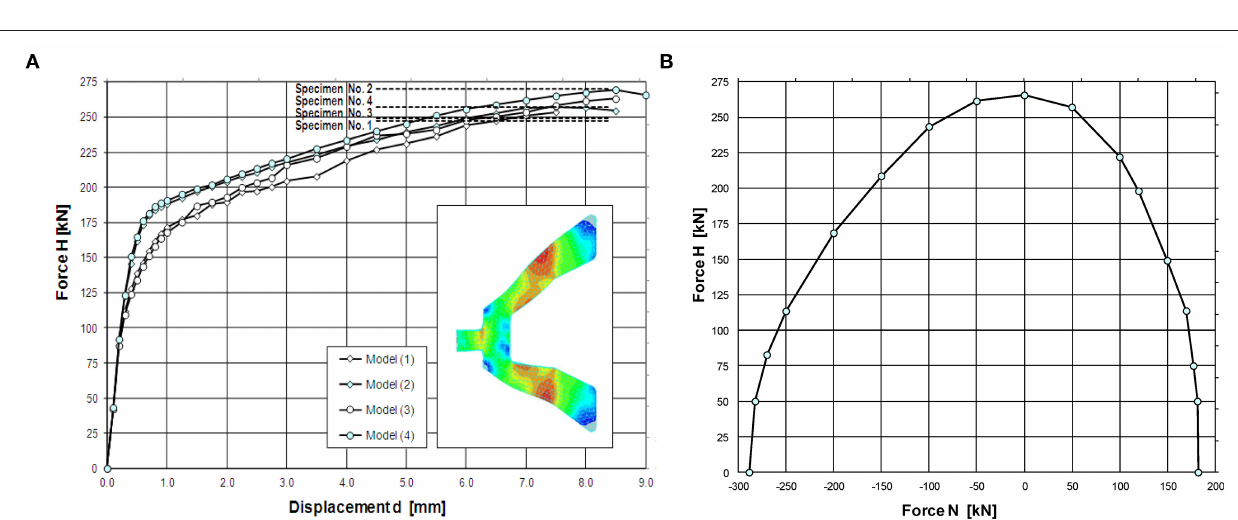
FIGURE 12 | Maximum displacement ratio of results from model with spread panel mass and lumped panel mass for the site: (A) Milano, (B) Napoli, and (C) L’Aquila.